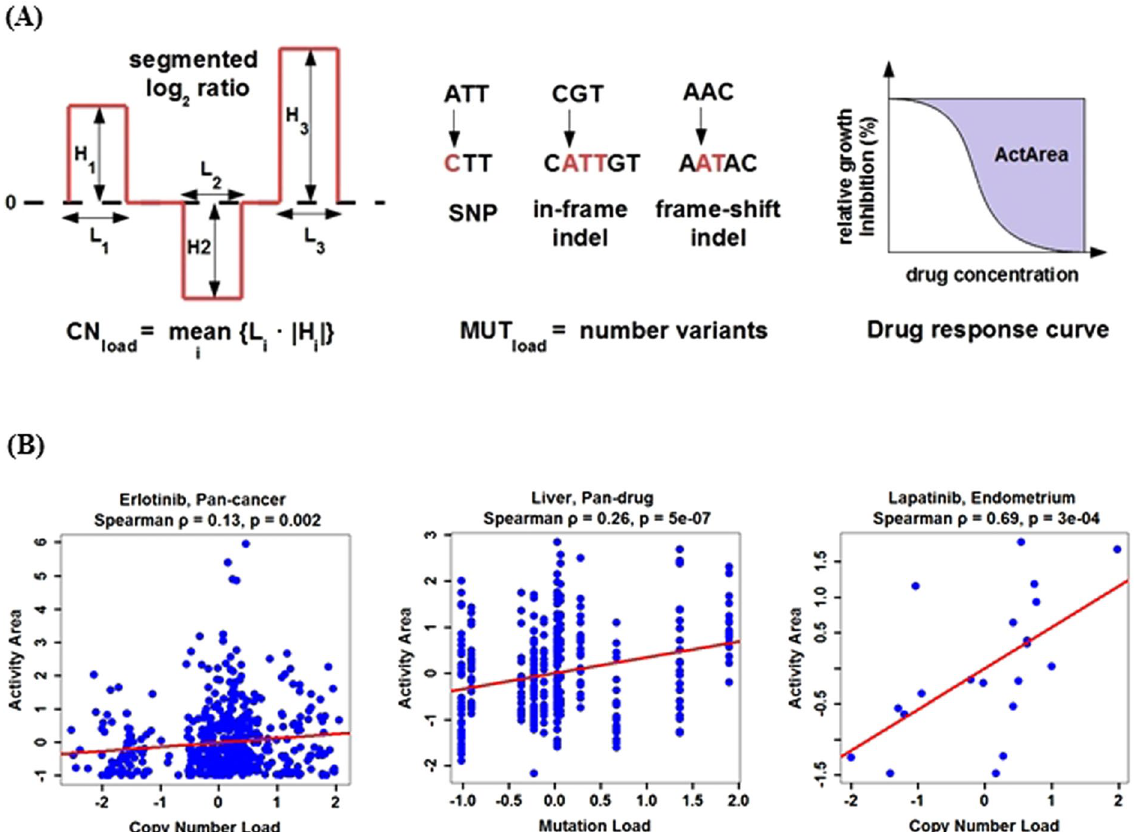
Figure 1. Testing the relationship between genetic load and drug sensitivity. ( A ) The first row illustrates the quantification of genetic load and drug sensitivity. From left to right: copy number load is measured as the mean absolute volume of amplifications and deletions, mutational load is defined as the total number of polymorphisms, and drug sensitivity is quantified by the area over the dose-response curve; see Methods for more details. ( B ) The second row illustrates three types of correlation analysis performed on the z-score normalized values: pan-cancer, pan-drug, and for specific tissue-drug combinations. Representative significant associations are shown. Note that the negative load reflects the normalization of genetic load accomplished by subtracting the mean load for the tissue type and then dividing by the standard deviation of the load in that tissue type.